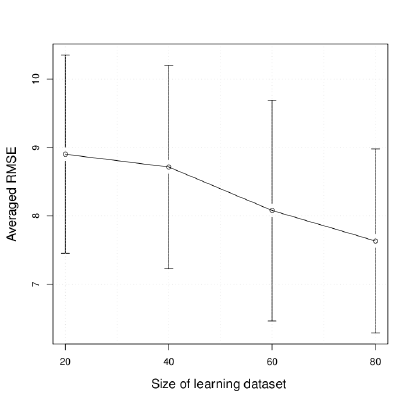
Figure 6: RMSE variations of predicted age as a function of the obser- vation number (each point is the average of 100